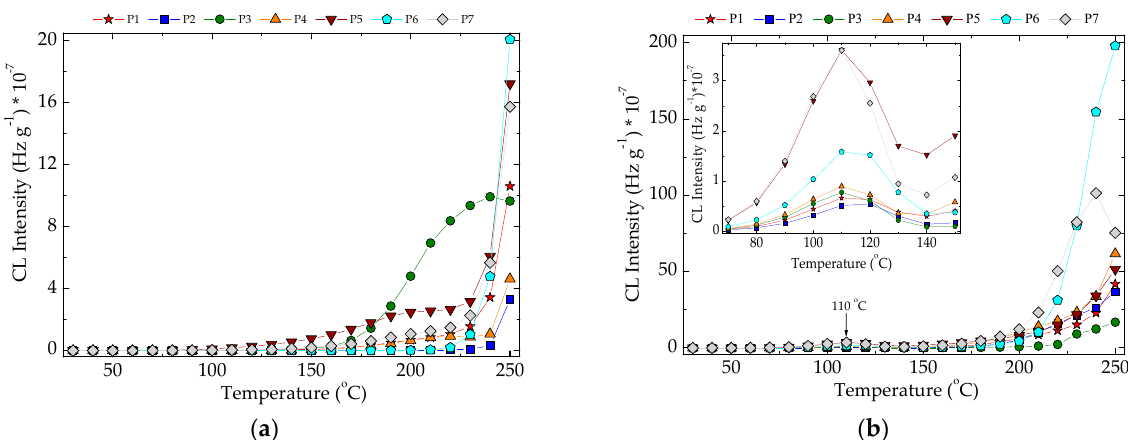
Figure 6. The nonisothermal CL spectra recorded on modified POSS powders. ( a ) neat materials; heating rate: 10.0 °C min − 1 ; ( b ) materials irradiate at 50 kGy, 15.0 °C min − 1 .